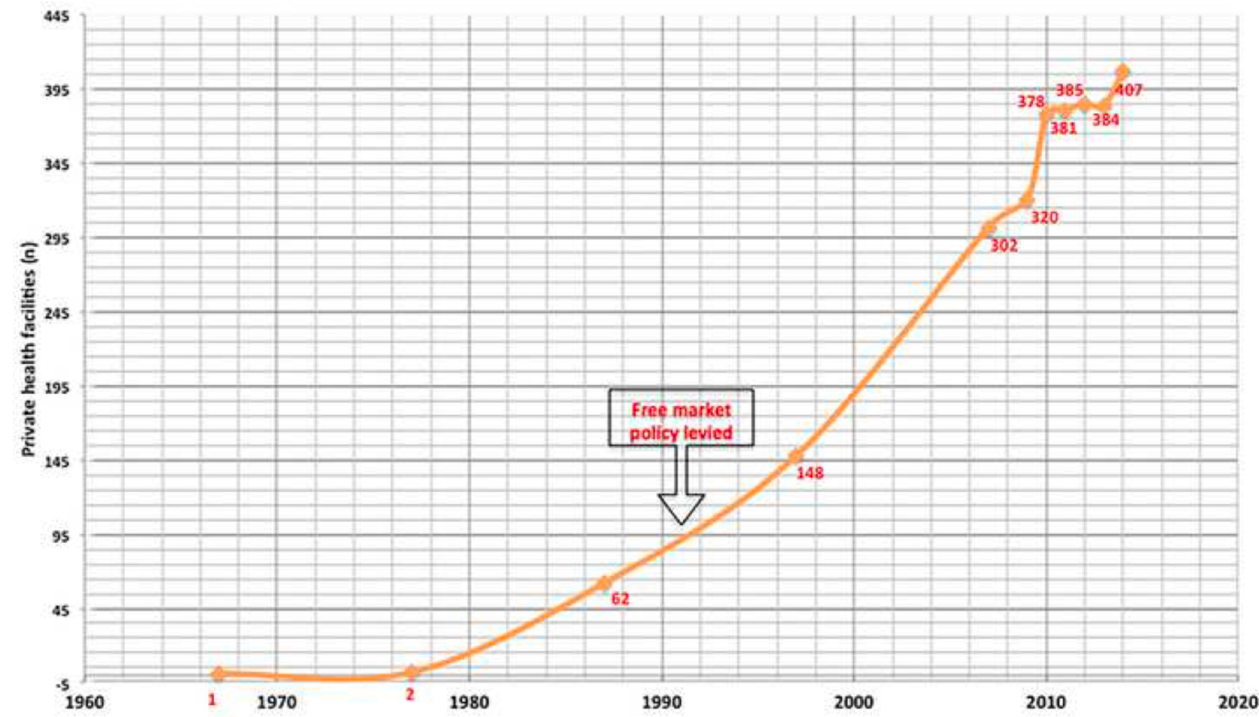
Fig 1. Private health sector growth in Burkina Faso. Sources: [42,